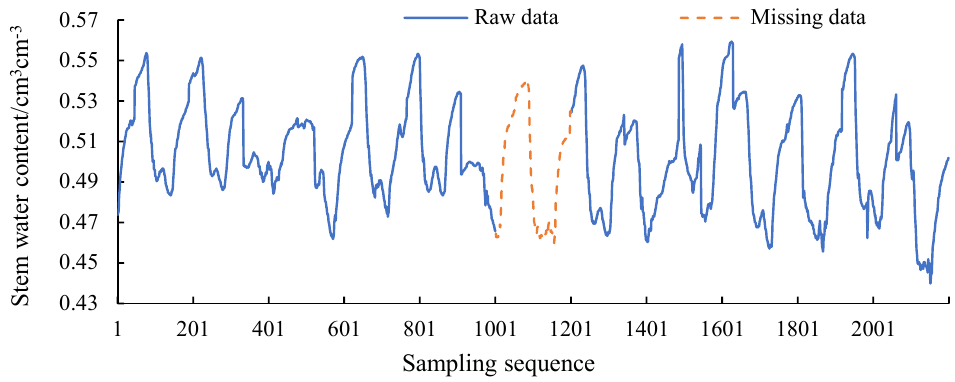
Figure 5. Series data of plant stem moisture.